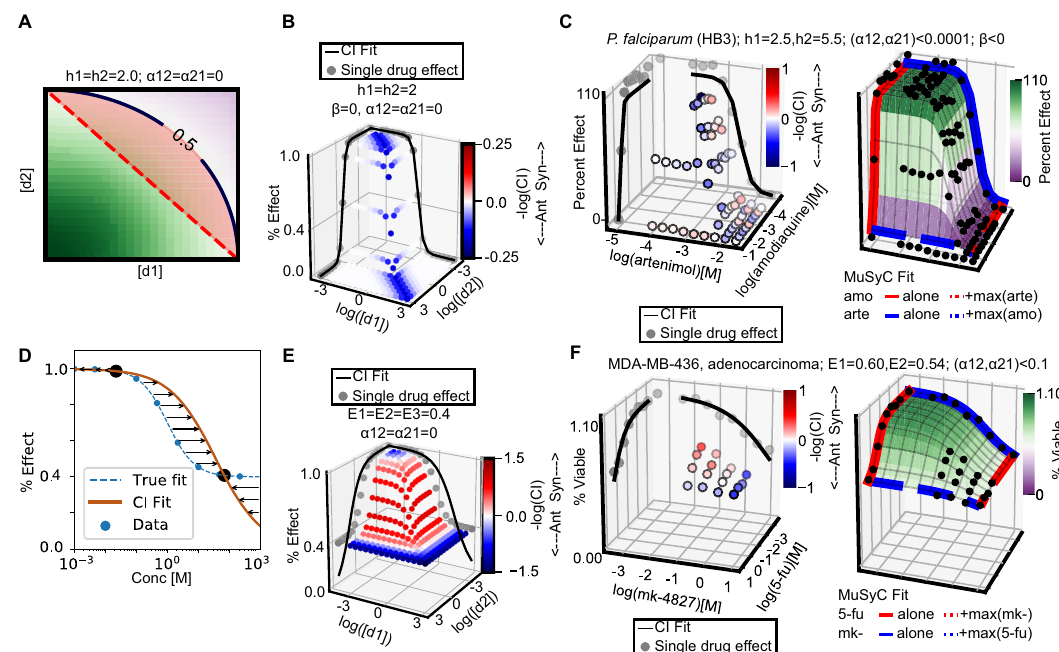
Fig. 6 Comparing MuSyC and CI. A Linear isoboles, characteristic of CI, emerge from MuSyC when the drugs are mutually exclusive ( α 12 = α 21 = 0) and h 1 = h = 1 (Fig. S2). When h ≠ 1, MuSyC predicts non-linear isoboles. Here, CI would erroneously assess dose pairs in the red shaded region (between 2 straight, dotted, diagonal line, and curved line above it) as antagonistic. B An example, synthetic two-drug dataset where this Hill-dependent bias is apparent ( h 1 = h 2 = 2, E 0 = 1, E 1 = E 2 = 0.0, C 1 = C 2 = 1, α 12 = α 21 = 0). This trend is most apparent near d 1 ≈ d 2 . C The combination of artenimol (alkylating agent) and amodiaquinine (putative inhibitor of heme polymerase activity) in the HB3 strain of malaria (chloroquine sensitive) 25 . Left panel shows the predicted CI bias (antagonism along diagonal due to h > 1). Right panel shows MuSyC ’ s fi t. Because E 0 = 1, E 1 = E 2 = 0, and ( α 12 , α 21 ) < 0.0001, the difference between MuSyC and CI, is due to the Hill slope error in CI. D A synthetically generated dose-response dataset (blue points) with ( E 0 = 1, E 1 = 0.4, C = 1, h = 1) is fi t using the CI method ( E = f ( d ), orange line), which assumes the effect must range from 100% to 0%. To calculate synergy, CI uses f − 1 ( E ) (orange line). Residuals in the CI fi t of f − 1 ( E ) to the true data are annotated with arrows. Black dots denote where the CI fi t and true curve (blue dotted line) cross. CI overestimates f − 1 ( E ) for effects between the black dots, and underestimates it for effects outside the black dots. When CI overestimates f − 1 ( E ), we expect it to overestimate synergy. Likewise, when CI underestimates f − 1 ( E ) we expect it to underestimate synergy. E A synthetic two-drug dataset with partially ef fi cacious drugs ( E 0 = 1, E 1 = E 2 = 0.4, C 1 = C 2 = 1, h 1 = h 2 = 1, α 12 = α 21 = 0) is analyzed with CI. As expected, in regions where CI overestimates f − 1 ( E ), it overestimates synergy (red), and likewise for underestimation (blue). F Experimental combination of drugs with intermediate ef fi cacy showing (left) CI ’ s effect-dependent bias and (right) MuSyC ’ s fi t. The combination is mk-4827 (PARP inhibitor) combined with 5-fu (thymidylate synthase inhibitor) in MDA-MB-436 breast adenocarcinoma 26 (BRCA1 mutant 51 ). Because MuSyC fi nds ( α 12 , α 21 ) < 0.1 and h 1 ≈ h 2 ≈ 1, the principle difference between the MuSyC model and CI relates to the effect range. As predicted, CI is antagonistic at the highest doses, despite these being the only doses which achieve greater effect than either drug alone ( β = parameters in MuSyC scales as 2 N ( N + 1) − 3 N − 1 (including γ )